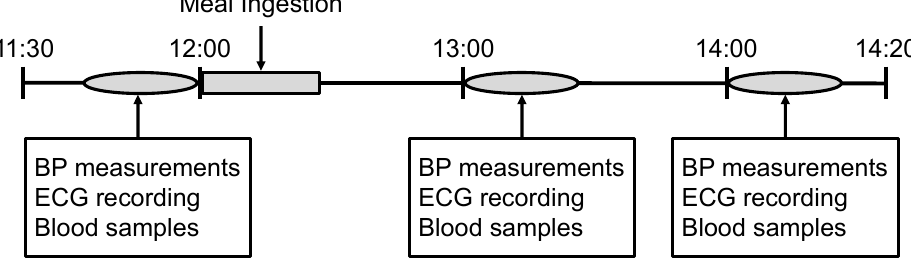
Figure 1. Experimental protocol. Abbreviations: BP, blood pressure; ECG, electrocardiogram.